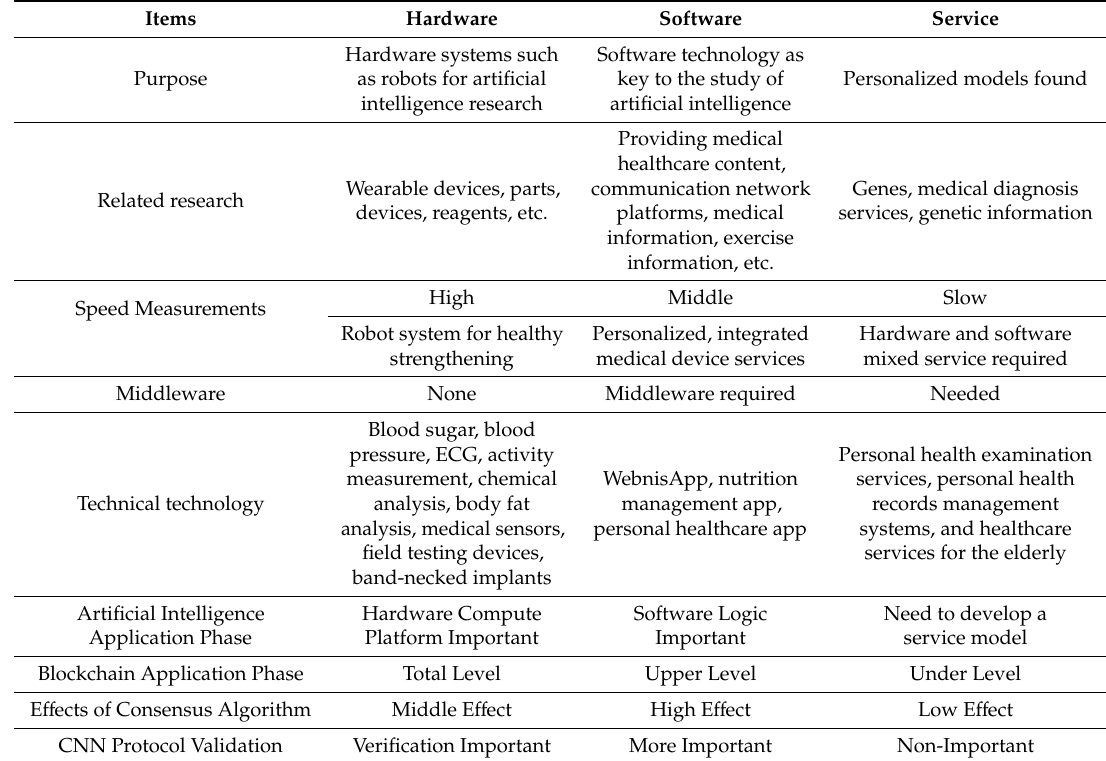
Table 1. Smart healthcare for hardware, software, and